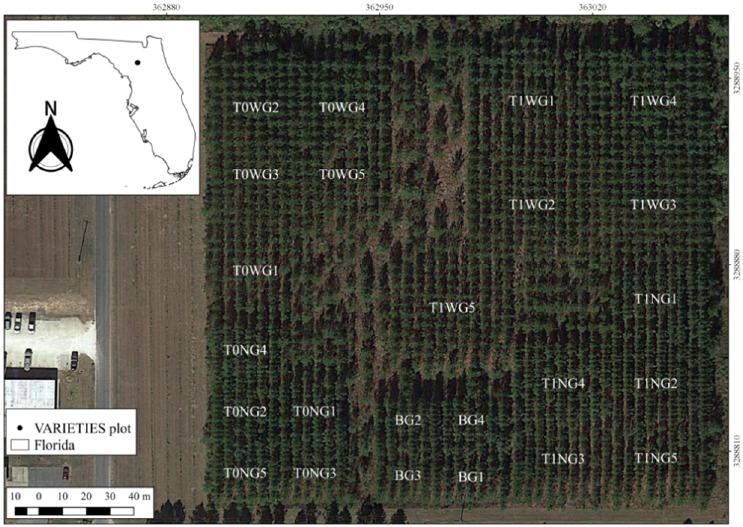
Figure 1. VARIETIES II plot map with genotype, spacing, and management codes (image courtesy of Google Earth). The management codes are explained above in Section 2.1.